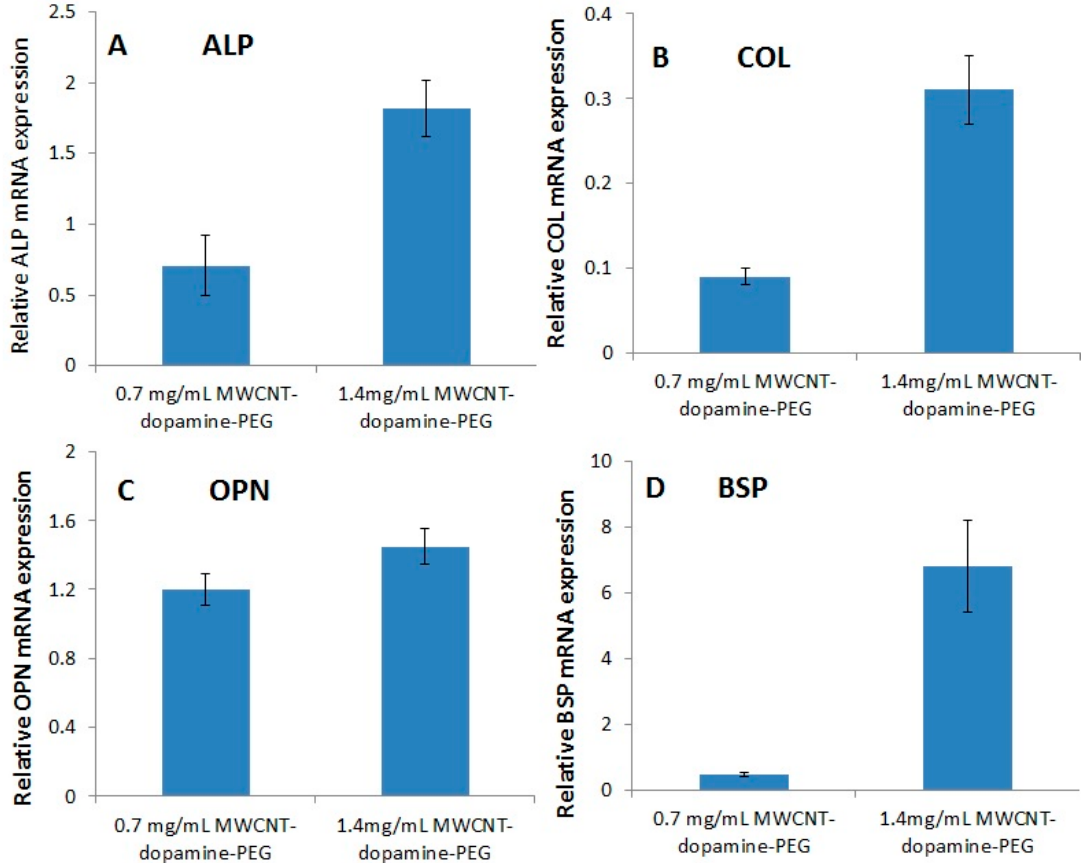
Figure 8. Real time qPCR of osteogenic gene expression levels of BMSCs cultured in vitro. Total RNA was prepared from BMSCs grown on hydrogels for seven days. ( A ) ALP (alkaline phosphatase); ( B ) COL (collagen I); ( C ) OPN (Osteopontin) and ( D ) BSP (bone sialoprotein) gene expressions were quantified using real time-qPCR methods; GAPDH was used as an internal control. Data values are expressed as mean ± SE ( n = 3)